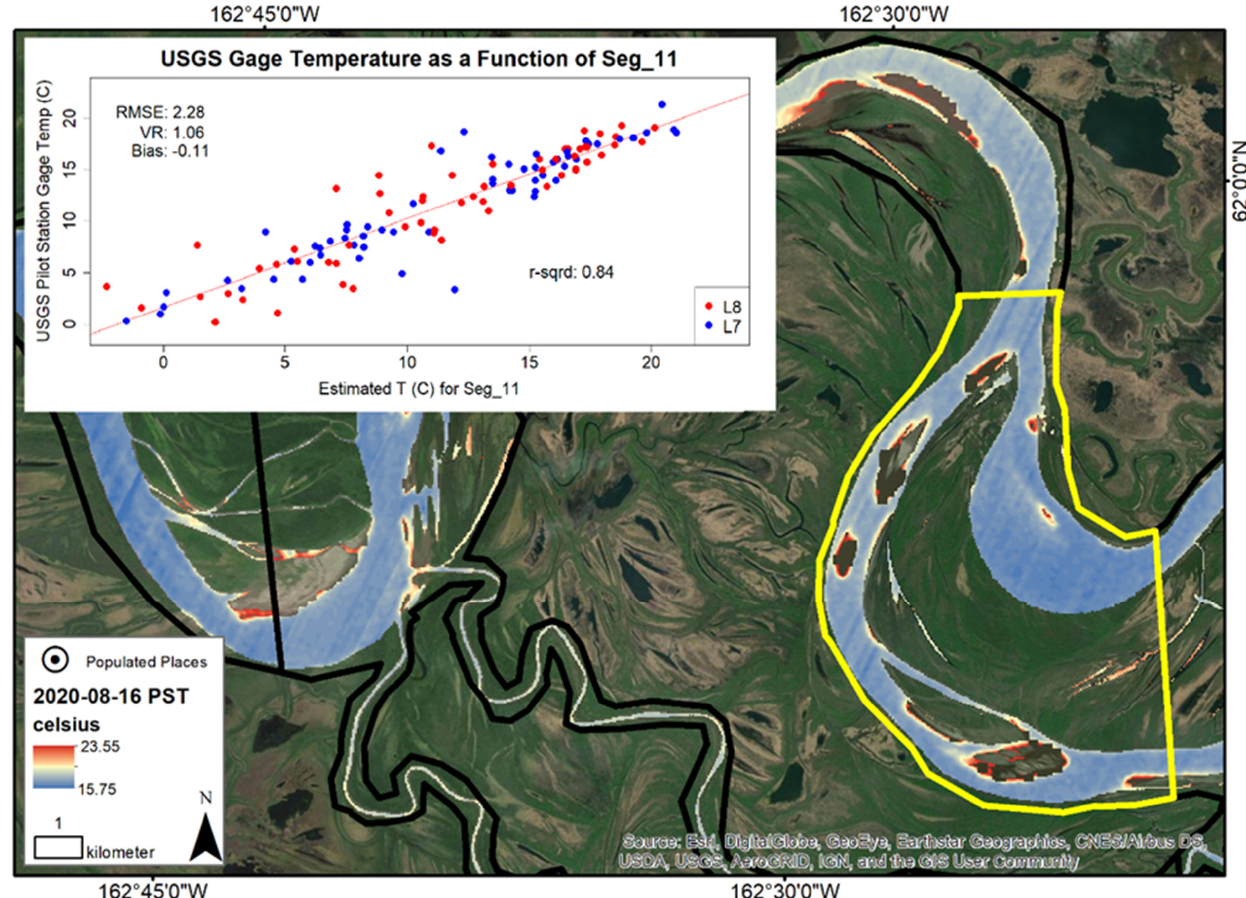
Figure A9. Within Segment 11, the Yukon transitions from two large channels to a single channel after Poltes Slough rejoins the main channel of the Yukon from the east. One small but permanent island lies within the main stem of the Yukon. Several smaller sandbars exist during low or moderate stages and are flooded at high stage. The pST coverage for open water within this section is nearly 100% with no significant NoData gaps. Wetlands surround all portions of this segment. Agreement between estimated water temperature and streamgage data is good (RMSE = 2.28 °C, r 2 = 0.84).